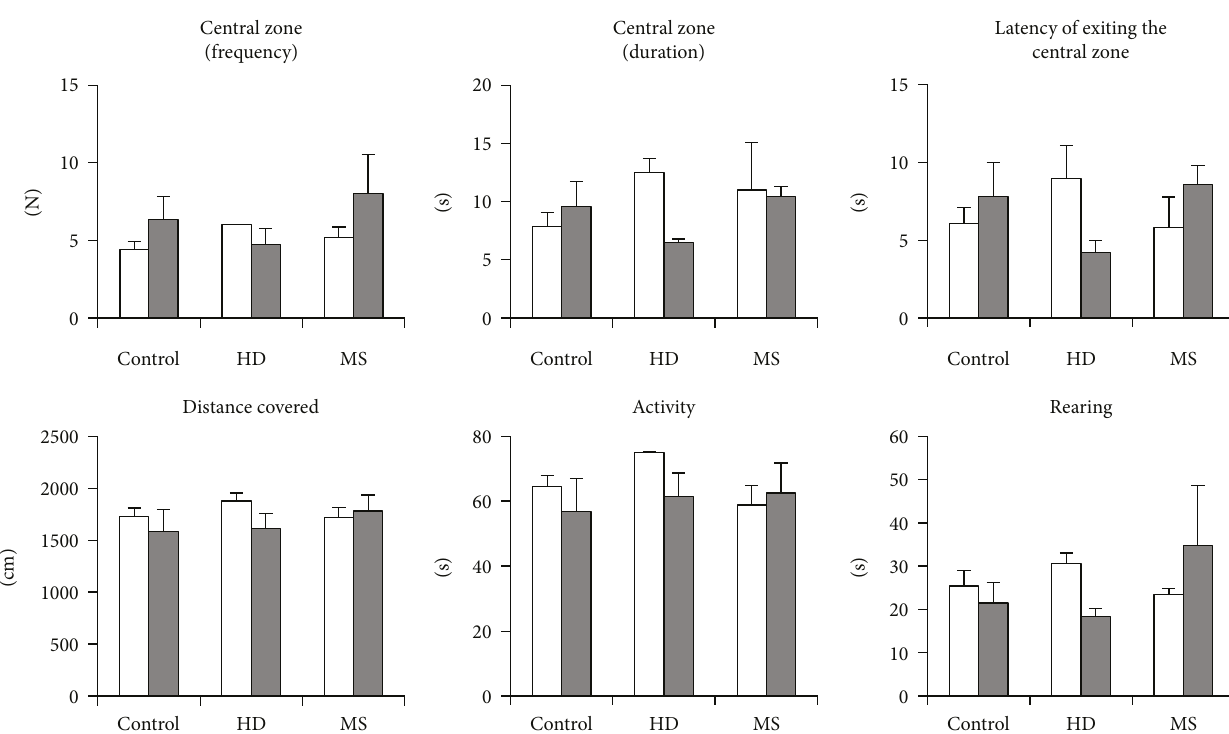
Figure 5: The in fl uence of early-life stress on the behavior of adult female mice in open- fi eld test in di ff erent phases of estrous cycle. Data present as mean ± standard error of the mean (SEM). White box: estrus (5 female controls, 2 HD group, and 5 MS group), gray box: diestrus (6 female controls, 4 HD group, and 3 MS group). Insu ffi cient number of mice in each phase did not allow a correct statistical analysis.